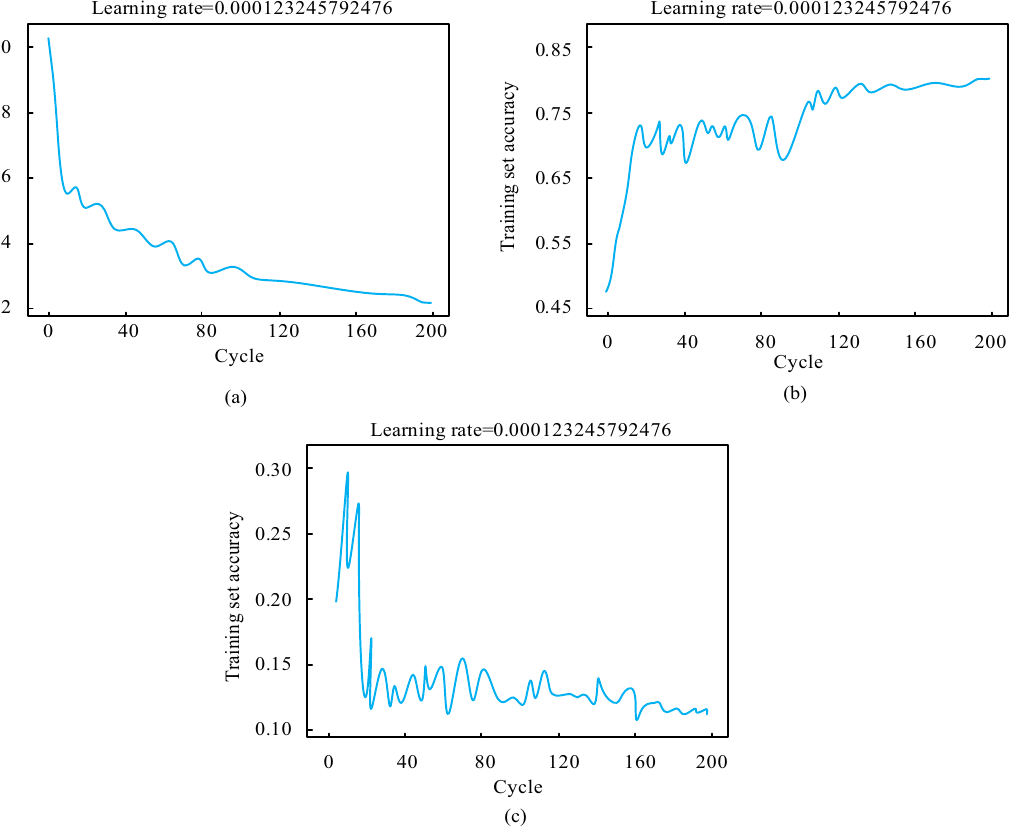
Figure 6: Cost and accuracy of encrypted datasets ( encrypted separately ) : ( a ) cost, ( b ) training set accuracy, and ( c ) validation set